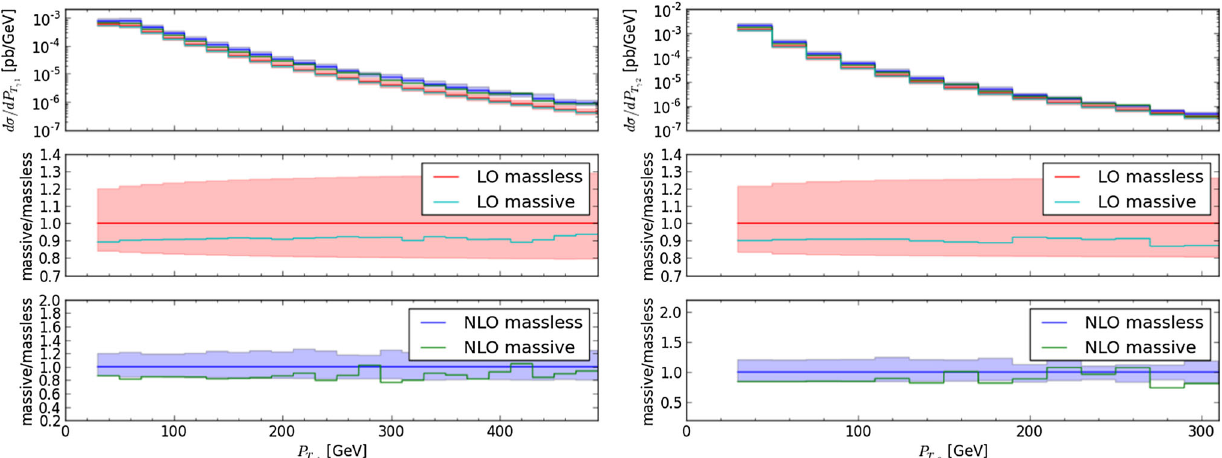
Fig. 9 Transverse momentum distribution of the two photons for massive b -quarks